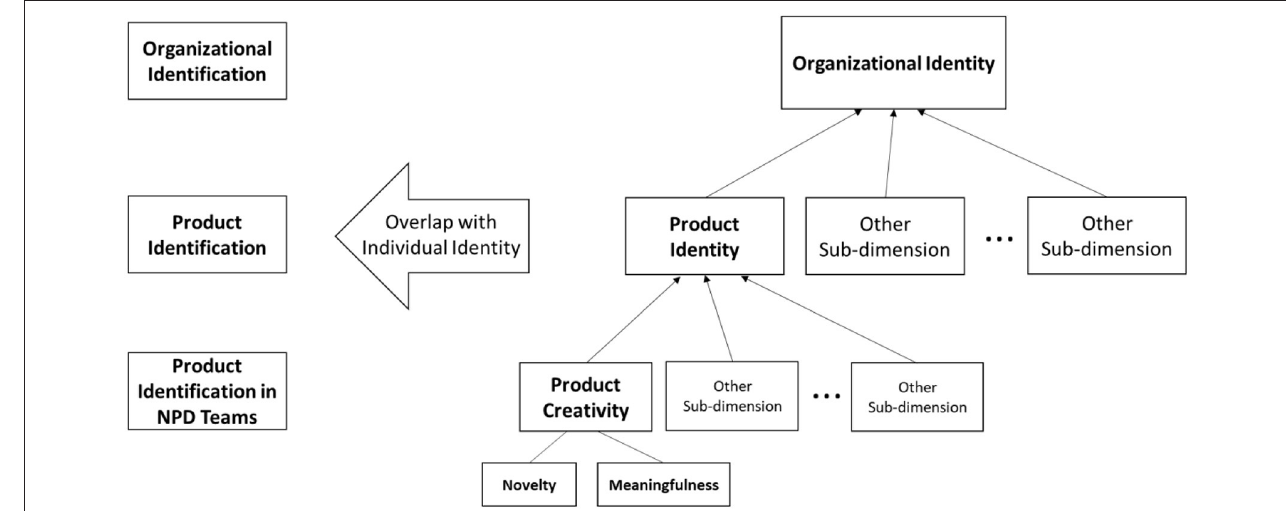
FIGURE 1 | Conceptual figure of product identification.